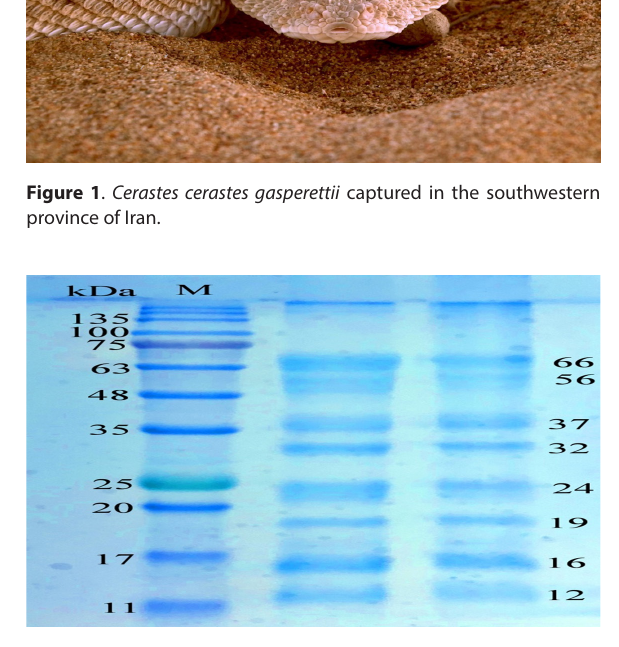
Figure 2. The protein constituents of the Cerastes cerastes gasperettii venom (lane 1:10 and lane 2:5 µg) were separated with the SDS-PAGE stained with the Coomassie blue. Numbers show the molecular weights of the